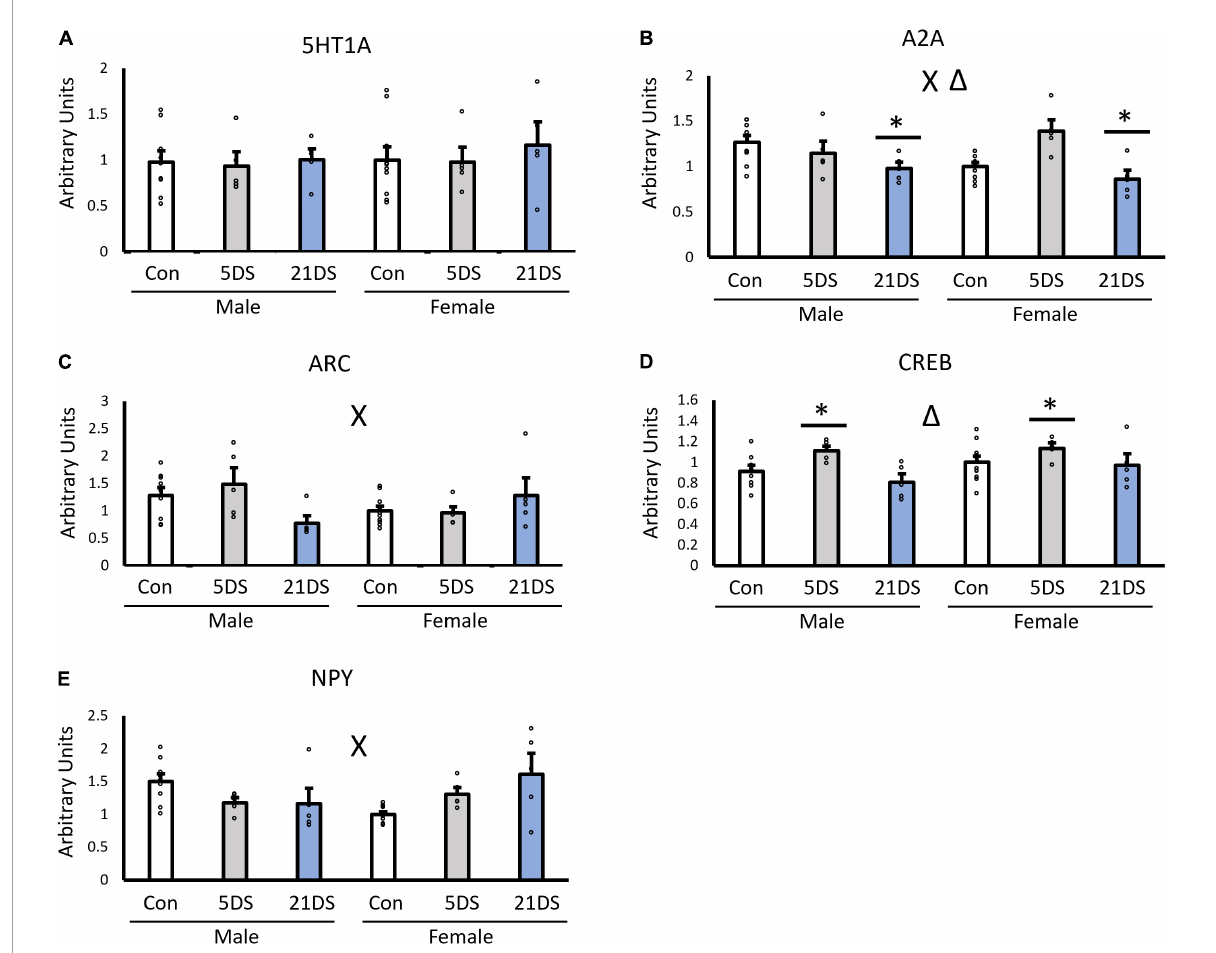
FIGURE2 Impact of chronic stress (21DS) and sub-chronic stress (5DS) on the expression of the 5-HT1A receptor (A) , the A2A receptor (B) , Arc (C) , CREB (D) , and NPY (E) in the NAc of male and female mice. N = 9 in the male control group, N = 10 in the female control group, and N = 5 in all other groups. (cid:49) Indicates a main effect of stress and X indicates a sex–stress interaction by two-way ANOVA ( p < 0.05). ∗ Significantly different from the other two stress conditions by Tukey’s post hoc